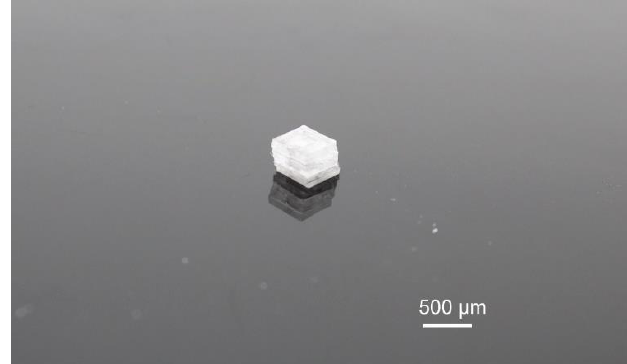
Figure 4. Fabrication process of ( a ) nontreated sensor and ( b ) UV-exposed sensor.